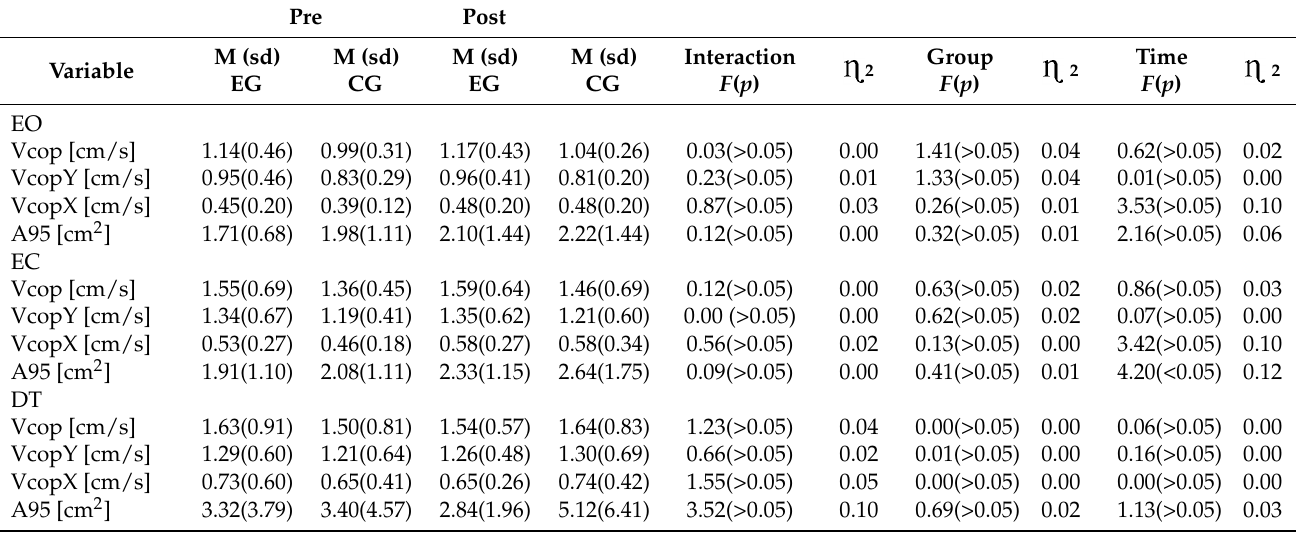
Table 2. Mean and standard deviation values for body balance for Eyes Open, Eyes Closed and Dual Task measures results of analysis of